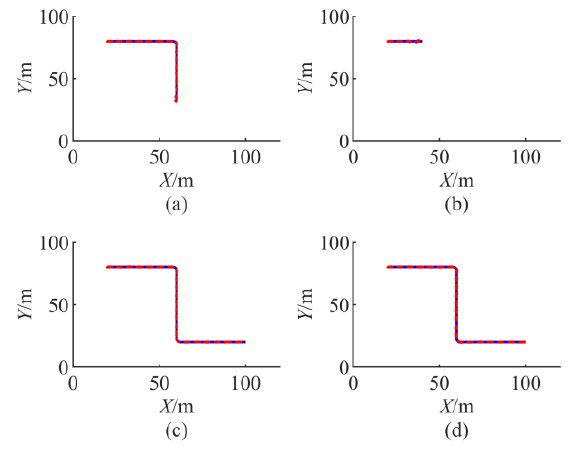
Figure 33. The trajectory with the positioning error in ±0.2m. The red line is the trajectory. The blue line is the reference path. ( a ) LMPC. ( b ) LEMPC. ( c ) NMPC. ( d ) NEMPC.